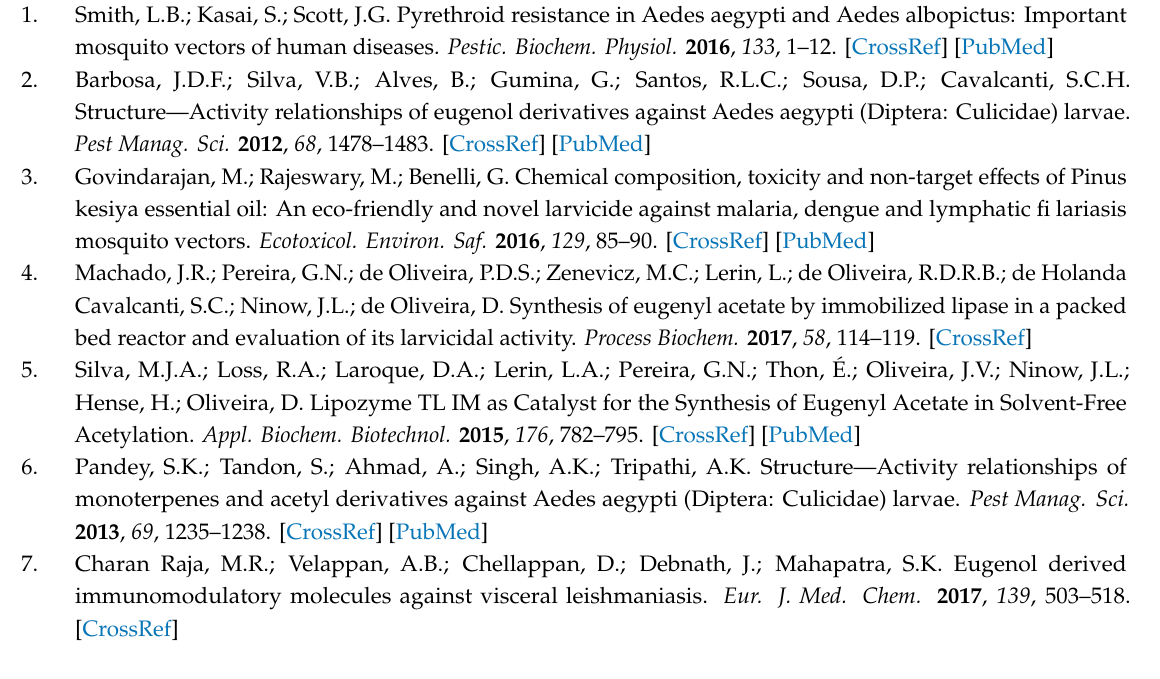
Figure S1: Eugenol and Eugenyl acetate FTIR spectra, Figure S2: Mass spectrometry (GC / MS) (a) eugenol, (b) eugenol and eugenol acetate, (c) acetate eugenol, Figure S3: Chromatograms (a) eugenol, (b) eugenol and eugenol acetate (autocatalysis), (c) eugenol and eugenol acetate (catalyzed with (3)SO3H / AlSiM), (d) eugenol acetate (catalyzed with (3)SO3H / AlSiM). Table S1: Chemical characterization of eugenol and eugenyl acetate by GC /